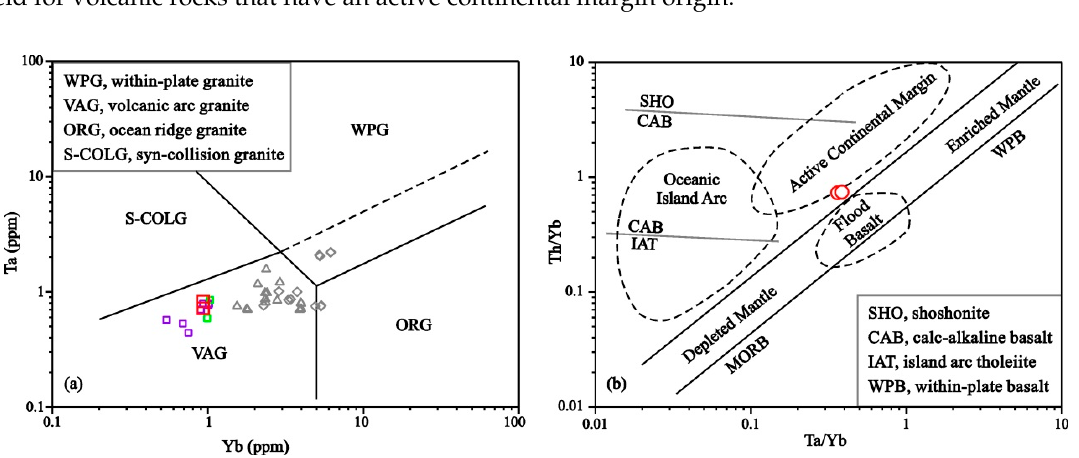
Figure 9. ( a ) Ta versus Yb discrimination diagram [58] for the SCS granodiorites of the present study and Mesozoic arc and adakitic granitoids from the South China Sea [23,24]. The symbols are as in Figure 6. ( b ) Th / Yb versus Ta / Yb diagram [59] for the NEBs sampled from the Xiaozhenzhu Seamount near the Zhongnan Fault in the